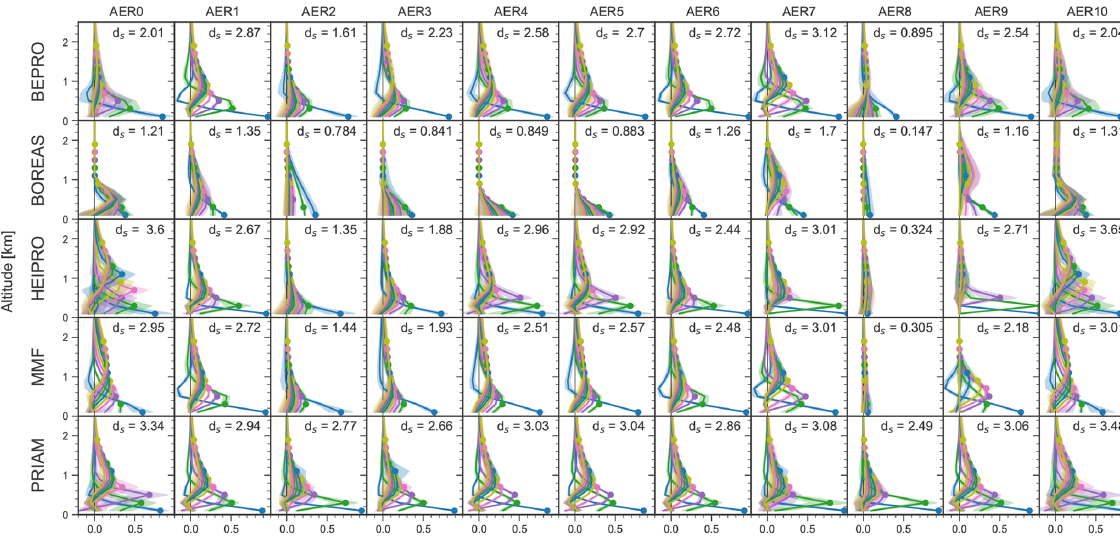
Figure 6. Same as Fig. 5, but for aerosols at 477nm.